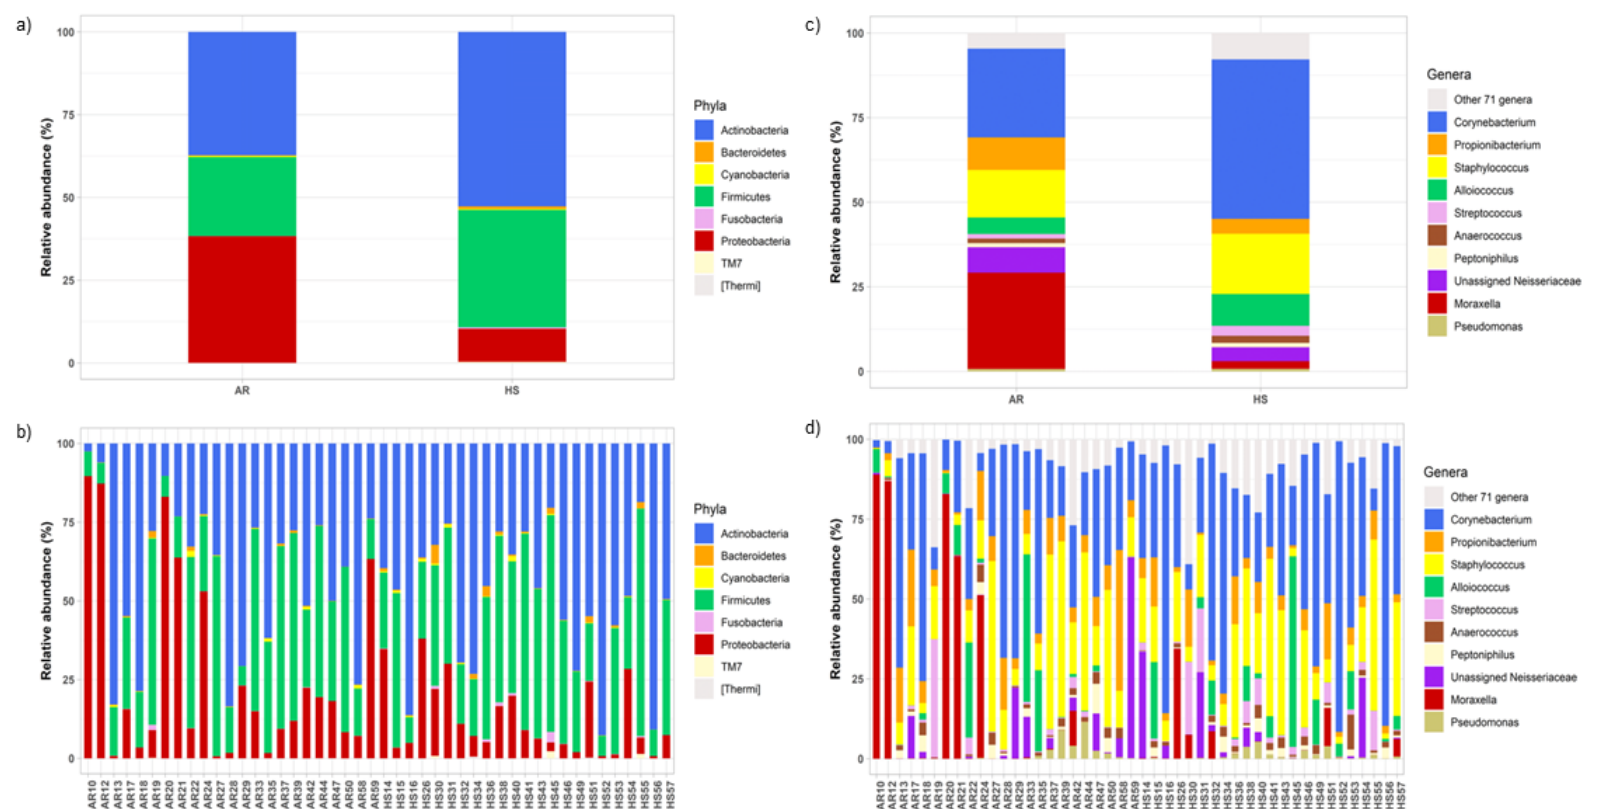
Figure 2. bNM phylum and genus-profile composition. ( a ) Average relative abundance of the bNM structure in the AR and HS groups; ( b ) relative abundance of the bNM of each enrolled subject; ( c ) average relative abundance in the AR and HS group; and ( d ) genus-profile structure of the bNM for each recruited subject. In addition, α -diversity analyses were performed to investigate compositional species richness and evenness within the study groups. The AR group was characterized by less diverse bNM compared to the HS group, as the bNM of the AR patients expressed a reduced mean richness and phylogenetic diversity compared to the HS group, as shown by the observed species ( p = 0.009), Chao1 ( p = 0.023), and the PD whole tree ( p = 0.009) indices (Table 4).